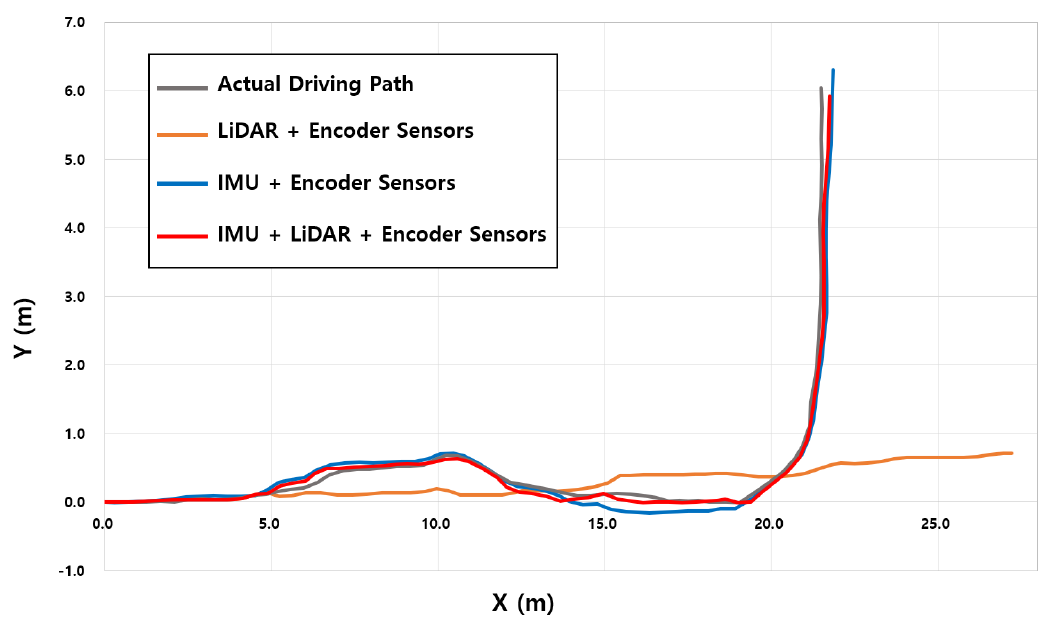
Figure 7. Autonomous robot’s driving path estimated by the three location estimation methods (inertial measurement unit (IMU) + encoder sensors, light detecting and ranging (LiDAR) + encoder sensors, and IMU + LiDAR + encoder sensors) and the actual driving path in the indoor experiment.